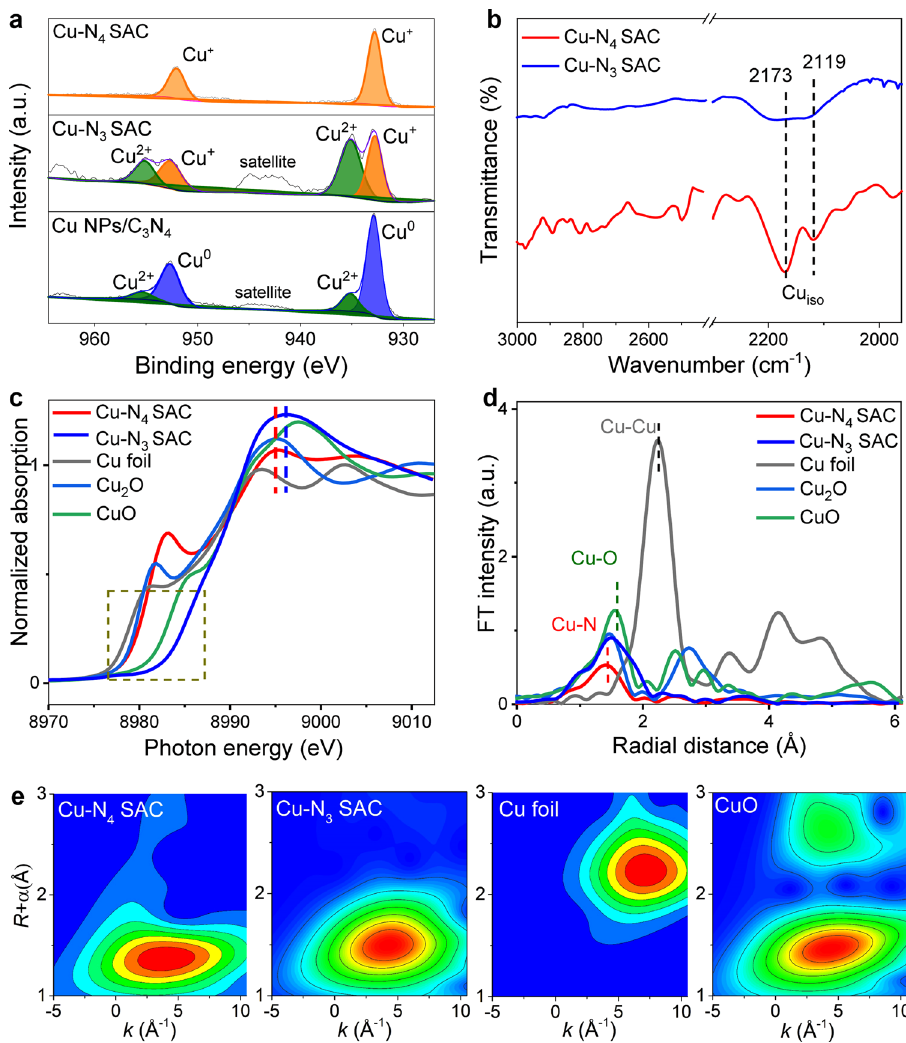
Fig. 2 Structural characterizations of various catalysts. a XPS spectra of Cu – N 4 SAC, Cu – N 3 SAC, and Cu NPs/C 3 N 4 . b CO-DRIFT spectra of Cu – N 4 and Cu – N 3 SACs. c XANES and ( d ) EXAFS spectra of Cu – N 4 SAC, Cu – N 3 SAC, Cu foil, Cu 2 O, and CuO at Cu K -edge. e Wavelet transform of EXAFS spectra at Cu K -edge. Source data are provided as a Source Data fi